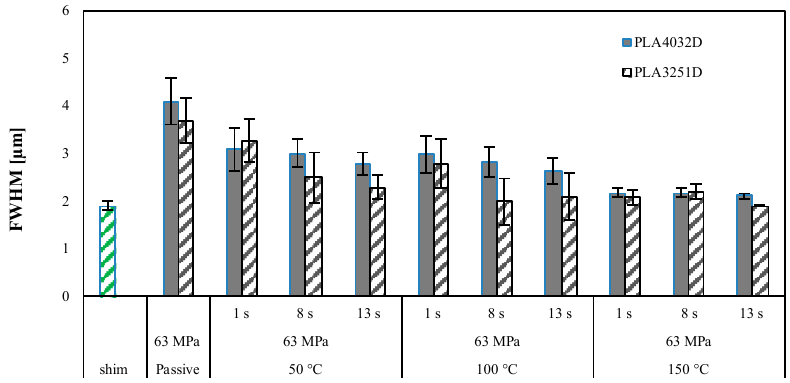
Figure 5. Comparison between the FWHM index, measured in the direction of the flow front, of micro-feature on PLA4032D and FWHM index of micro-features on PLA3251D samples obtained as indicated in Table 1.